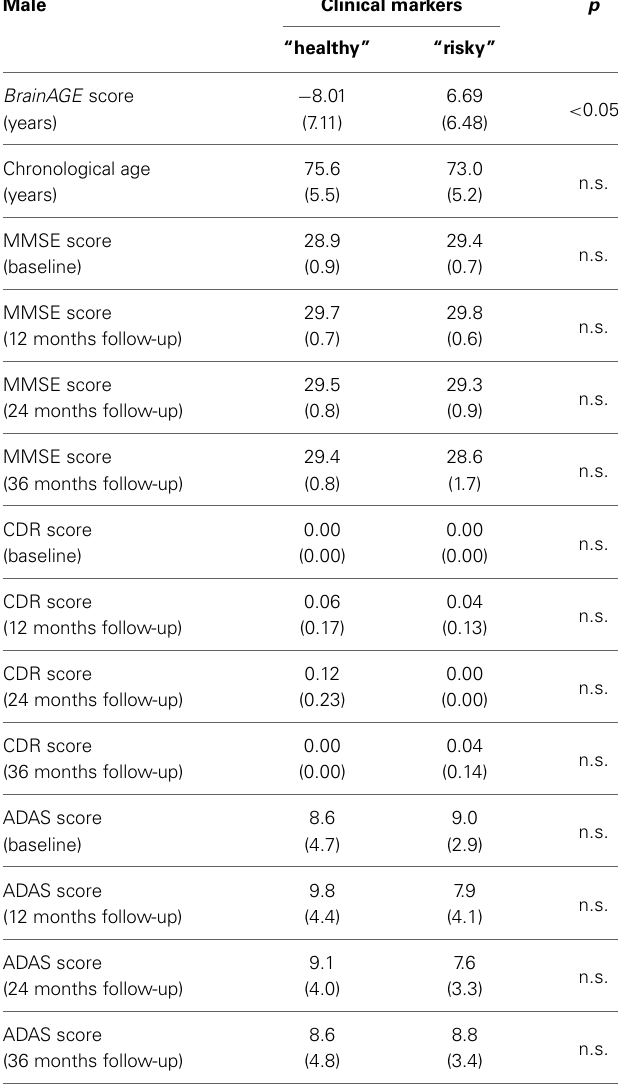
Table 5 | Means ( SD ) of BrainAGE scores, chronological age, and cognitive scores in male subjects with “healthy” clinical markers (i.e., values equal to or below the medians of BMI, DBP, GGT, and uric acid) vs. “risky” clinical markers (i.e., values equal to or above the medians of BMI, DBP, GGT, and uric